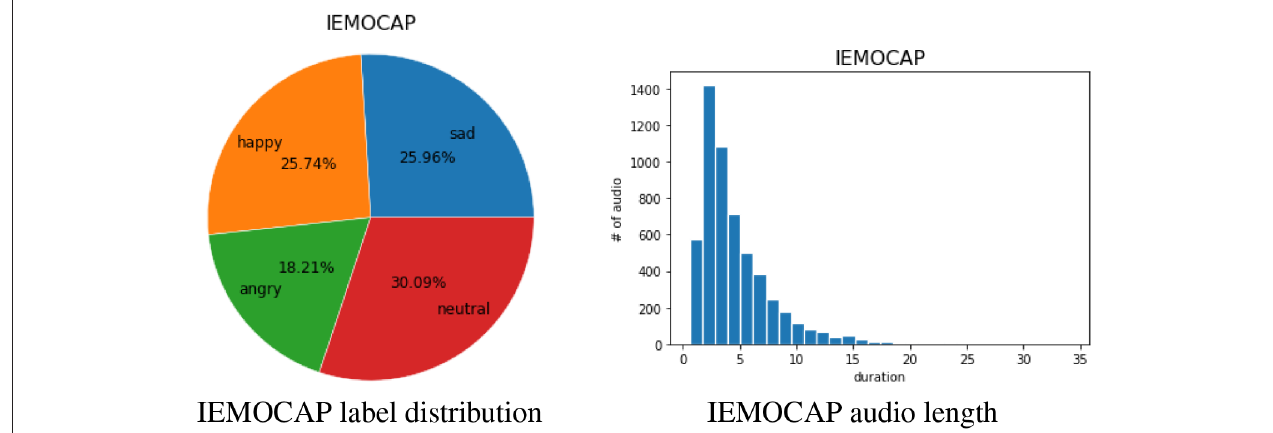
FIGURE 1 | The 4-class emotion label distribution and the audio length distribution of IEMOCAP